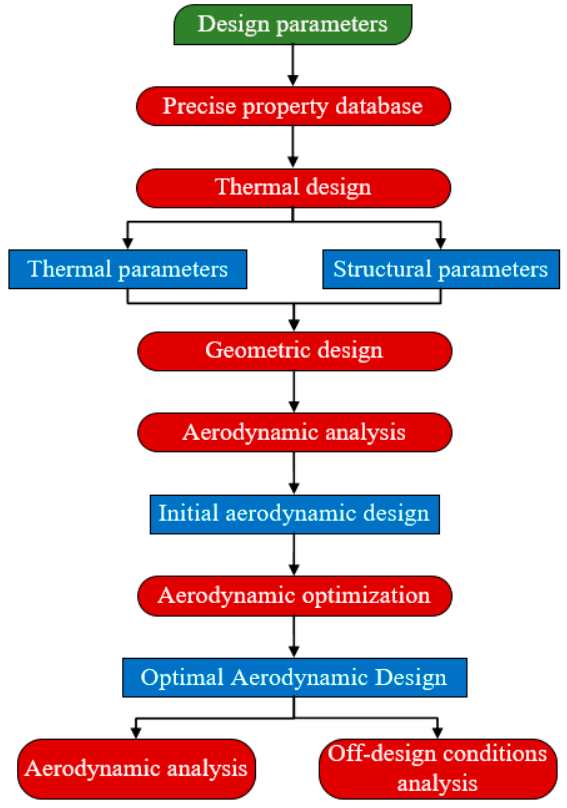
Figure 1. Research flow chart.